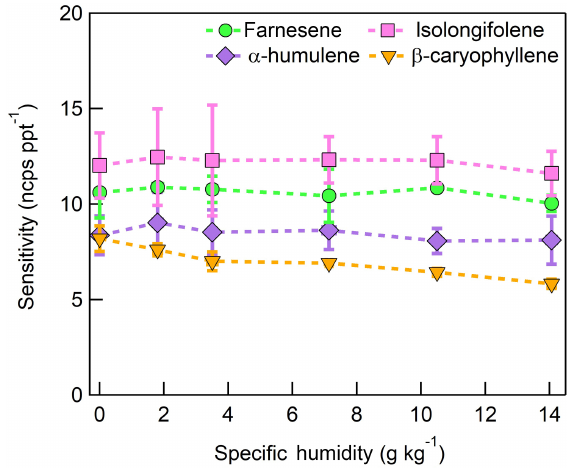
Figure 14. Humidity-dependent, normalized sensitivities to sesquiterpenes, reported as the sum of the major product ions (C 15 H + , 203 m/Q ), (C 15 H + , 204 m/Q ), and (C 15 H 24 O + 23 24 236 m/Q ). Error bars represent the standard deviation of triplicate